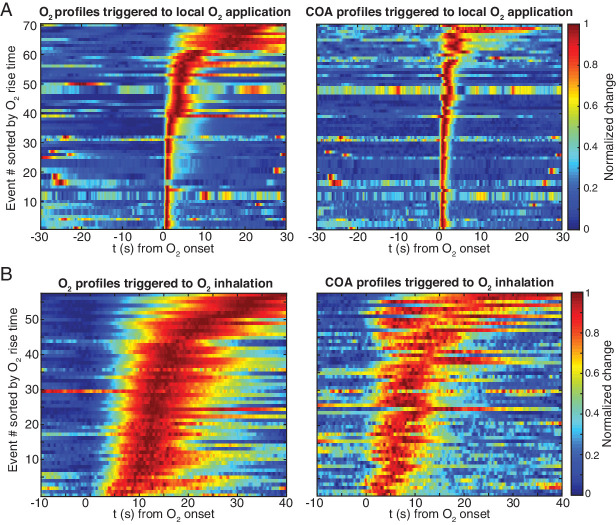
Raw sensor responses evoked by exogenous oxygen in vivo.(A) Normalized O2 and COA transients evoked by local O2 application, sorted by O2 rise time. Events were obtained from three recording sessions (n = 13–40 per session). (B) Normalized O2 and COA transients evoked by O2 inhalation, sorted by O2 rise time. Events were obtained from three recording sessions (n = 8–40 per session).